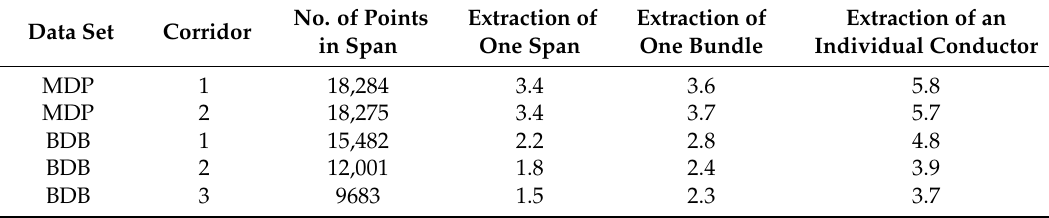
Table 9. Processing time (in minutes) for each